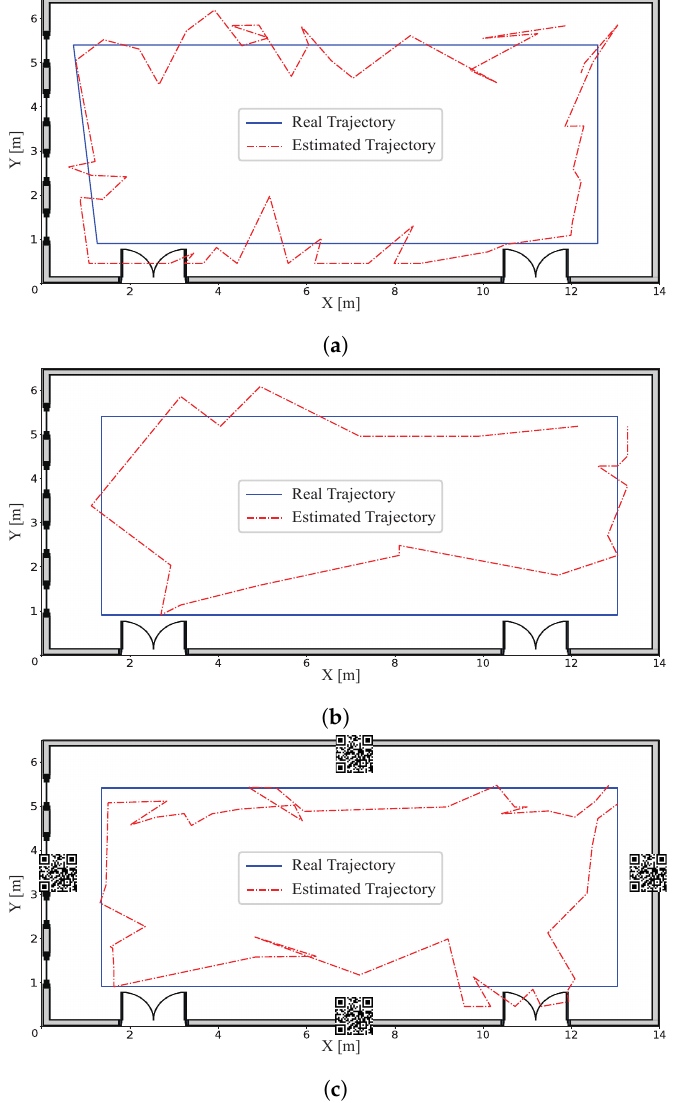
Figure 15. Estimation of moving trajectory in the hall. ( a ) Moving trajectory of user measured with App. 1. ( b ) Moving trajectory of user measured with App. 2. ( c ) Moving trajectory of user measured with App.